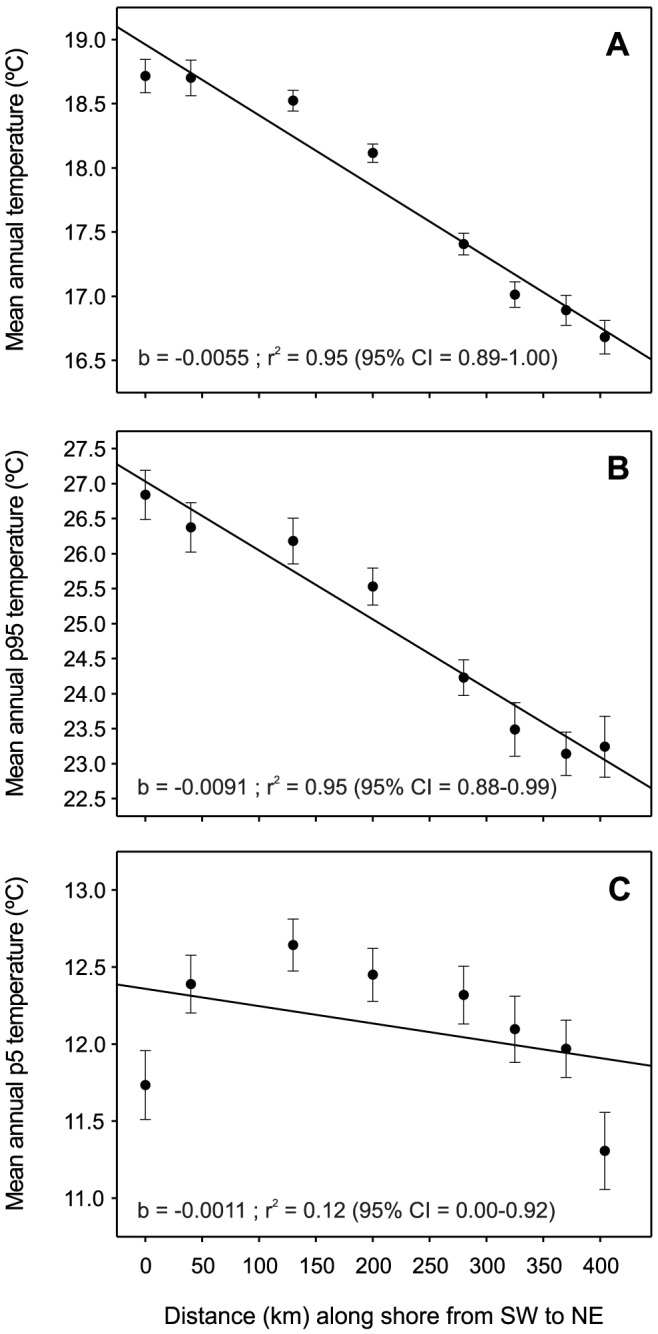
Sea surface temperature (SST) obtained from NASA satellite measurements over the last 8 years (2003–2010).See Fig. 1 and Table S1 for a description of the studied locations (n = 8). A) Mean annual temperature; B) mean annual temperature 95th percentile (p95); C) mean annual temperature 5th percentile (p5). Pearson product-moment correlation between the distance (km) along the shore from SW to NE (see Fig. 1) and the temperature along the Catalan coast. 95% CI: 95% confidence interval calculated with bootstrapping.